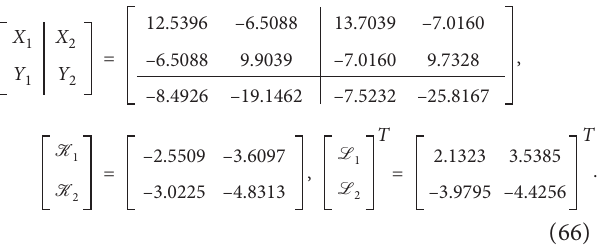
( t ) with estimation 􏽢 x 2